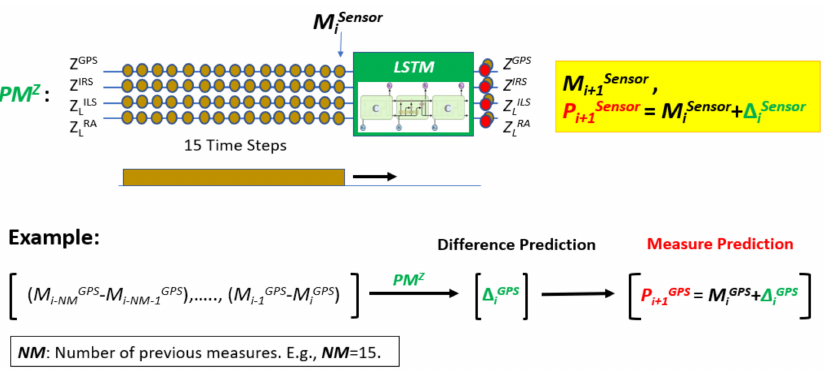
Figure 3. PM Z prediction. In the lower part, an example of measure prediction for the GPS is